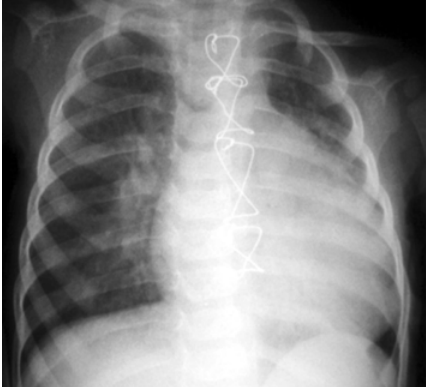
Fig. 1 - Radiograma de tórax em posição póstero-anterior, no 13º dia de pós-operatório, com atelectasia basal à direita